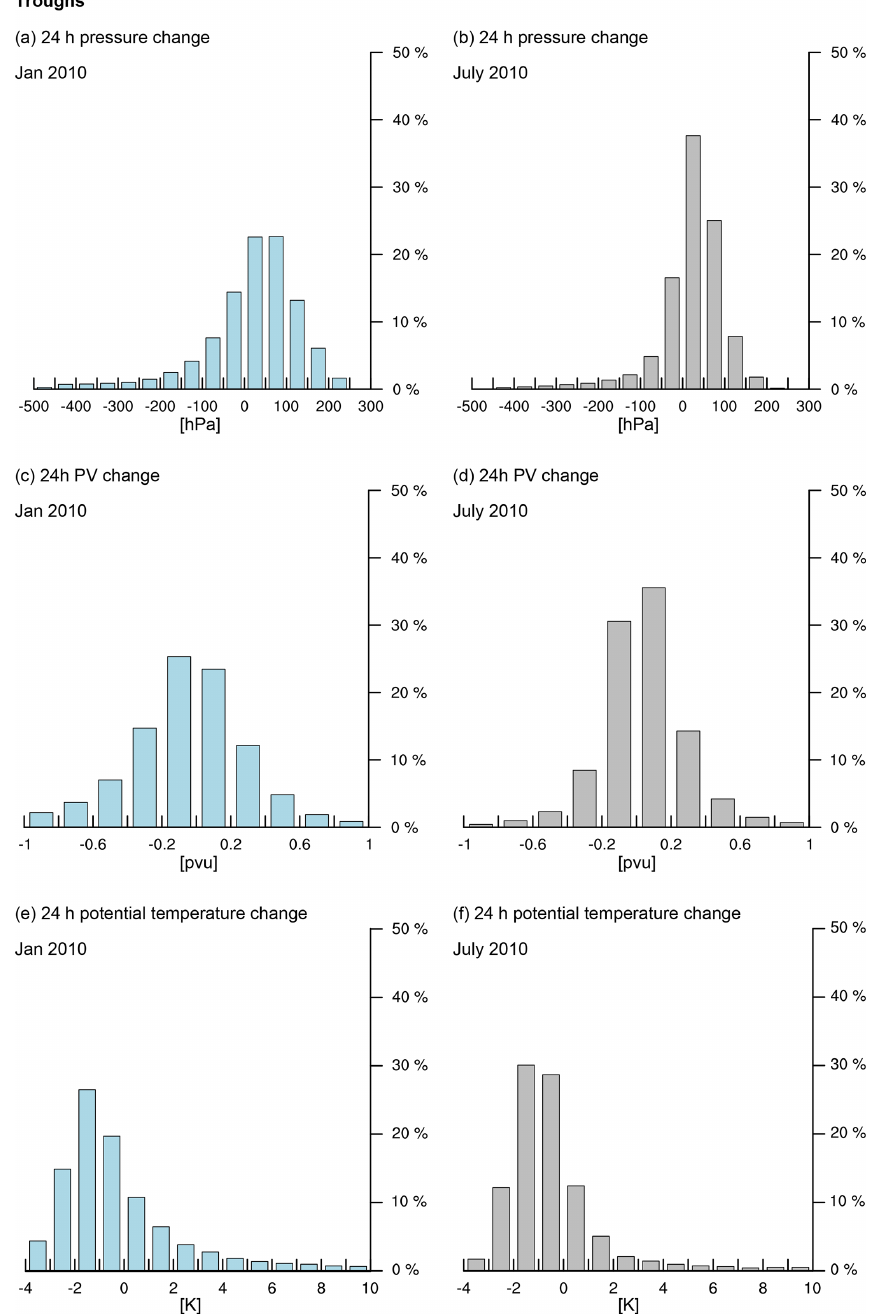
Figure 9. Histograms of the change (a, b) in pressure (hPad − 1 ), (c, d) potential vorticity (pvud − 1 ), and (e, f) potential temperature (Kd − 1 ) along the air parcel trajectories released from all troughs detected at the 500hPa level during (a, c, e) January and (b, d, f) July 2010.